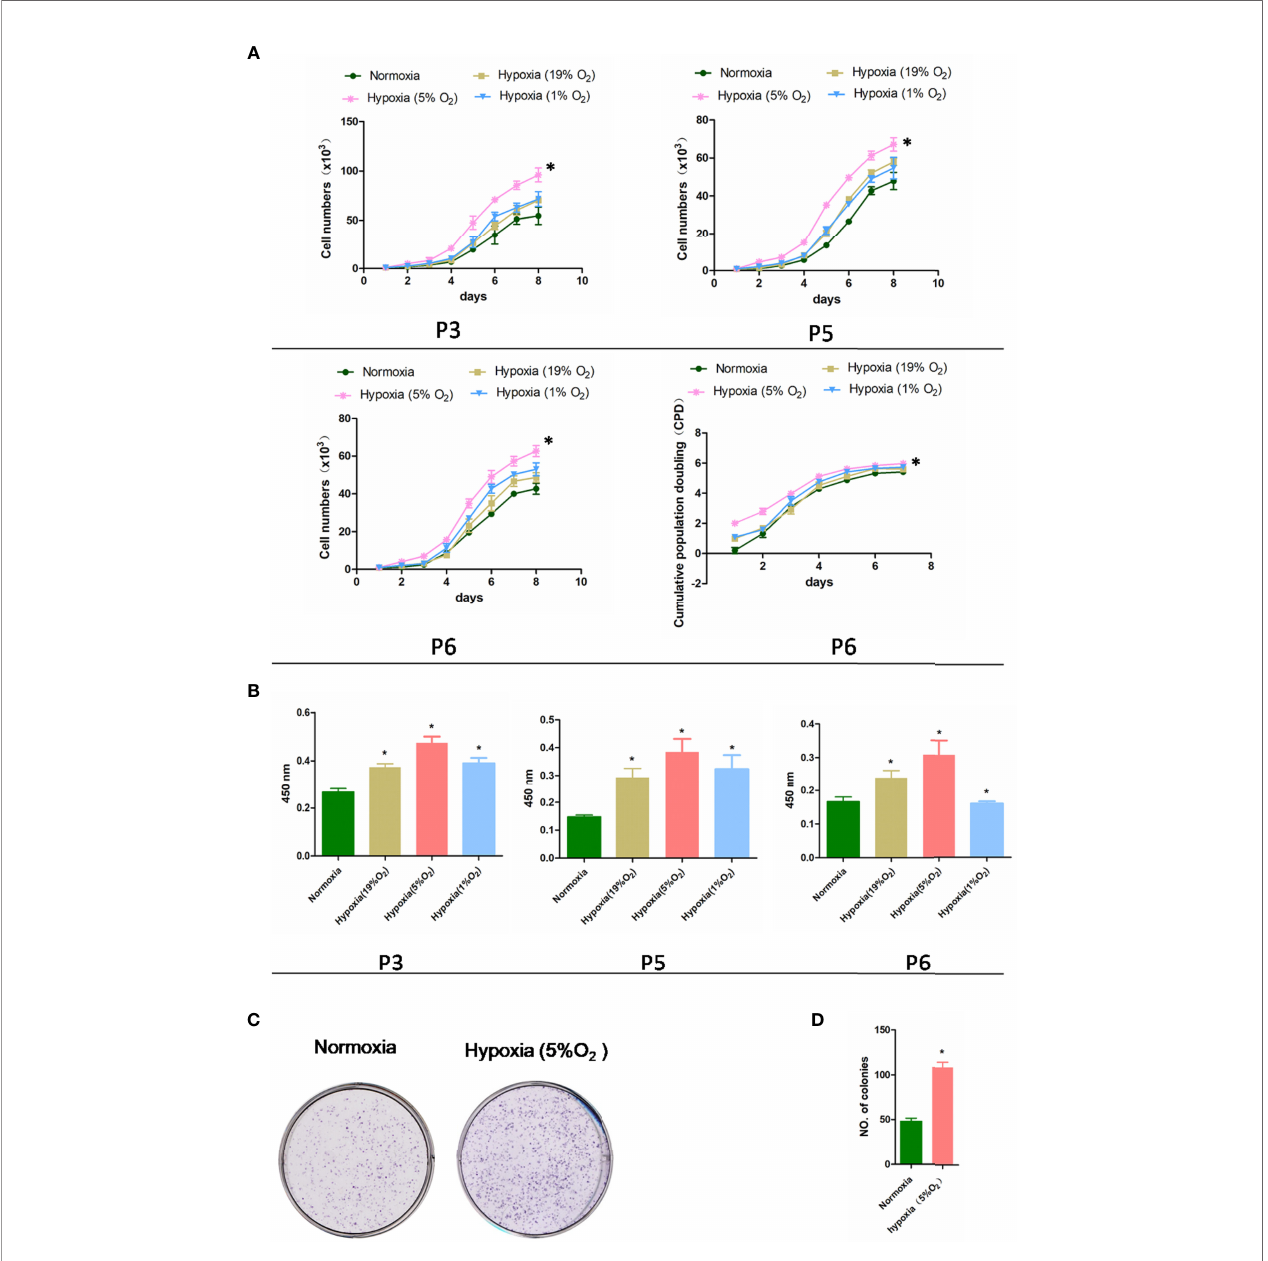
FIGURE 2 | Effect of hypoxia on rPBMSC proliferation. (A) The cell growth curves of third-generation PBMSCs (P3 PBMSCs), fi fth-generation PBMSCs (P5 PBMSCs), and sixth-generation PBMSCs (P6 PBMSCs) were drawn based on the number of cells counted at each time point, the cumulative population doubling curve of sixth-generation PBMSCs (P6 PBMSCs) was determined based on cell culture time. (B) Absorbance of P3, P5, and P6 rPBMSCs treated under normoxia and hypoxia (5% O 2 ) at Day 8. (C) Hypoxia increased the number of rPBMSC colonies. (D) Measurement of the number of colonies in each group. All data are presented as means ± SEM. P < 0. 05; ∗ vs control group. rPBMSCs, rat peripheral blood-derived mesenchymal stromal